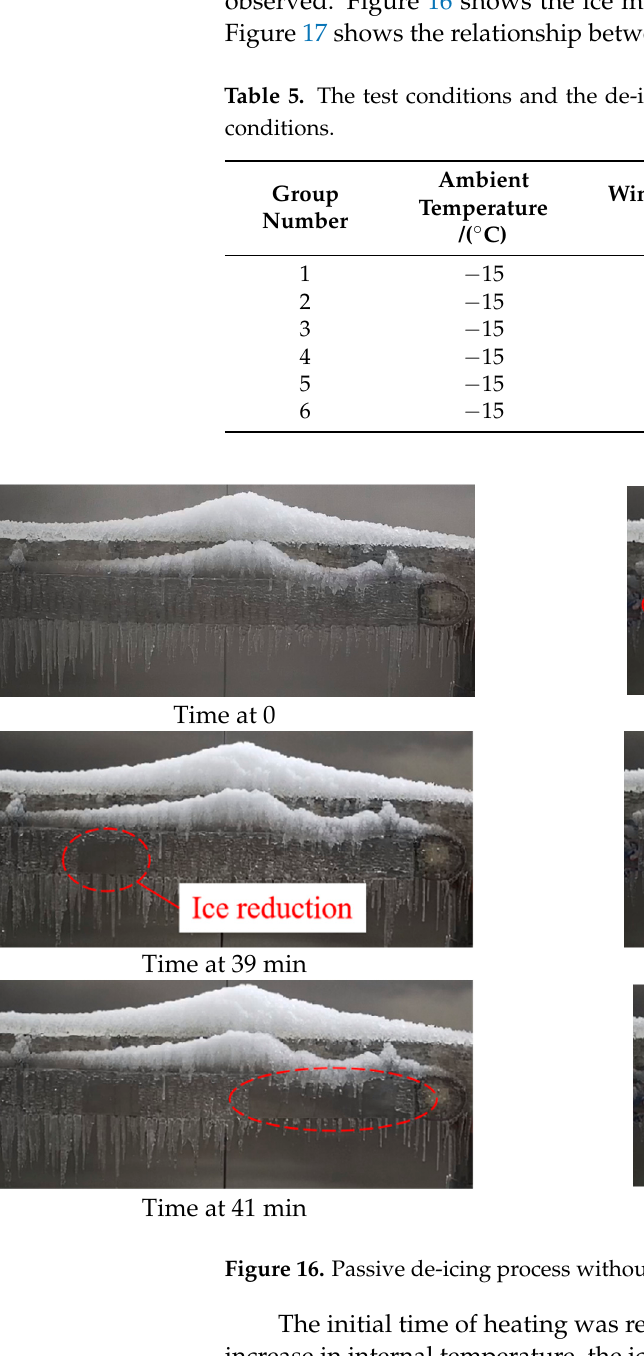
Figure 17. Variation of the de-icing time period with the wind velocity.